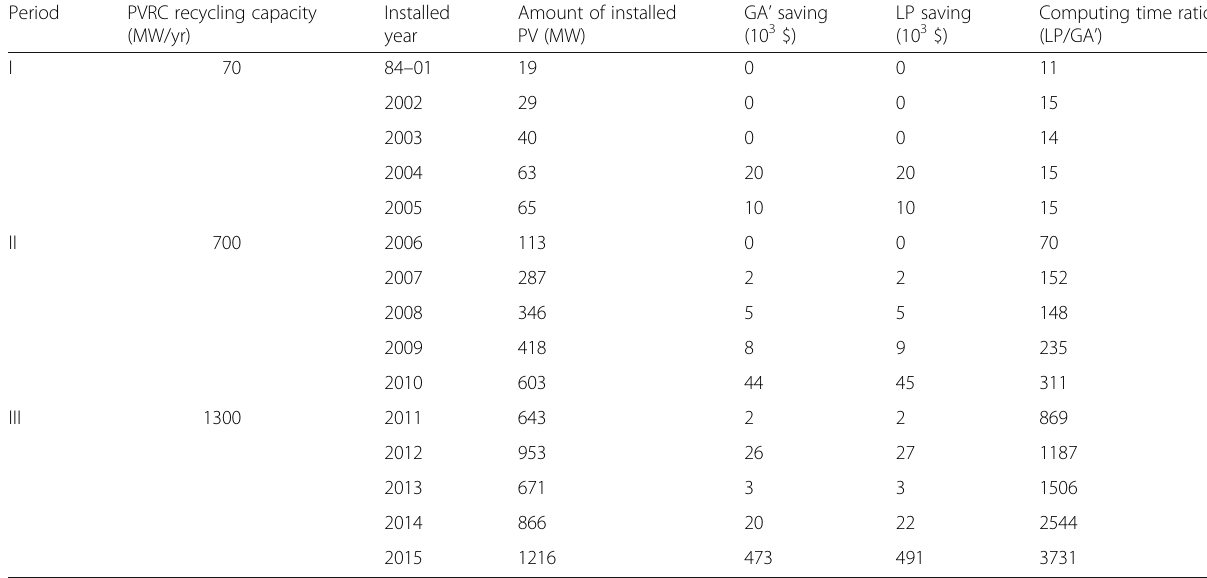
Table 2 Saving of GA ’ and LP of each year Period